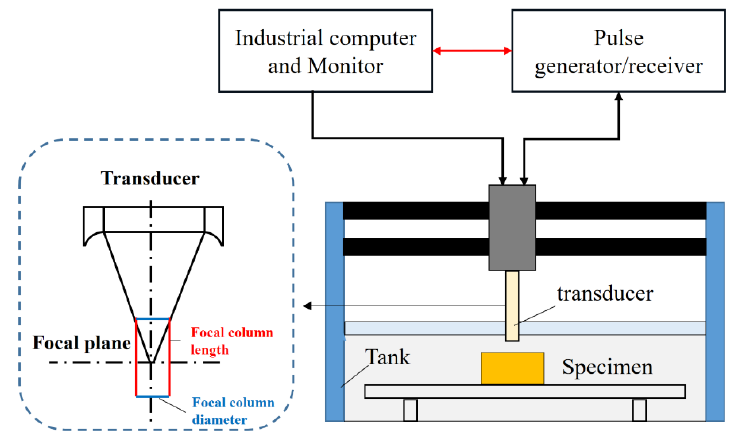
Figure 2. Schematic diagram of Ultrasonic Detection [28].